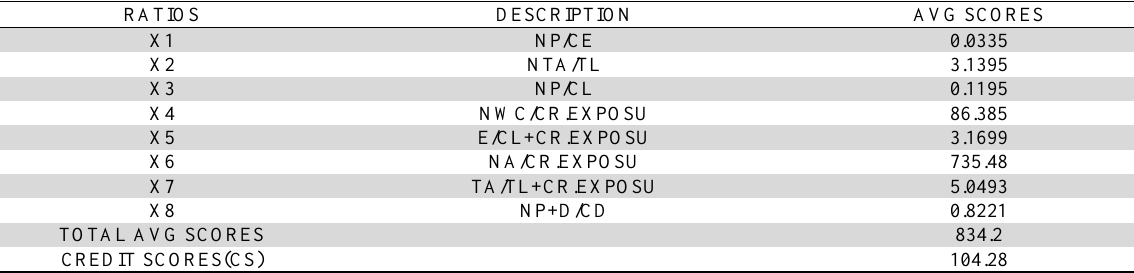
Risk Description Model – Ratio Measurement (Khaitan)